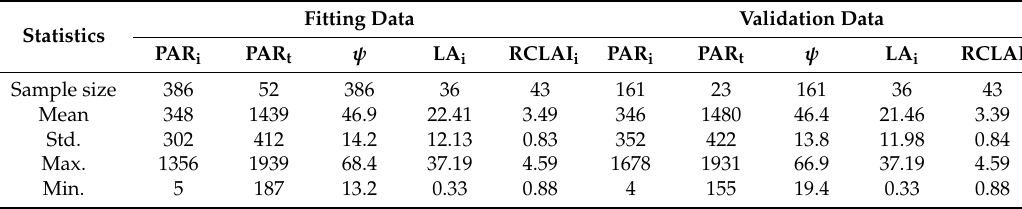
Table 2. Summary of the main measured variables. The following variables are given: the photosynthetically active radiation in each pseudowhorl (PAR i ), incident PAR at the top of the crown (PAR t ), the solar elevation angle ( ψ ), leaf area in each pseudowhorl (LA i ), relative cumulative leaf area index in each pseudowhorl (RCLAI i ). i is the serial number of pseudowhorls belonging to five planted Larix olgensis